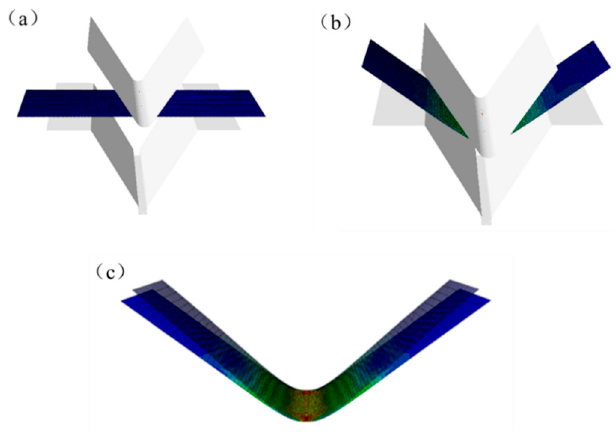
Figure 2. Finite element simulation process ( a ) before bending, ( b ) after bending, and ( c ) after springback.